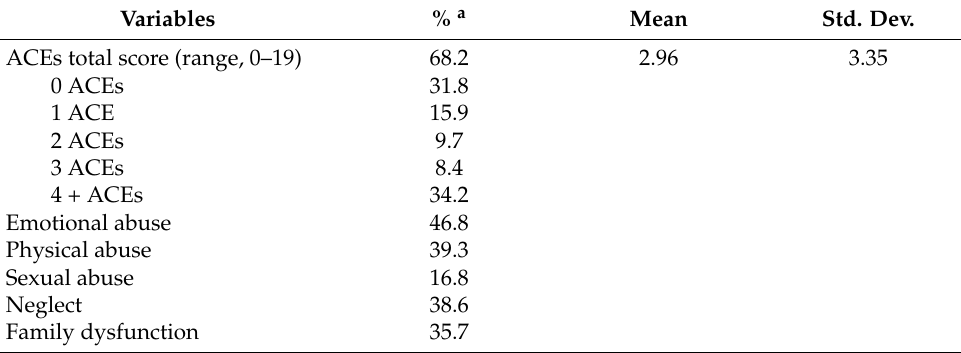
Table 2. Adverse Childhood Experiences among the rural population (N = 338).